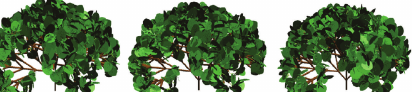
Figure 9: Response of petiole and leaves to wind: consecutive frames of animation.